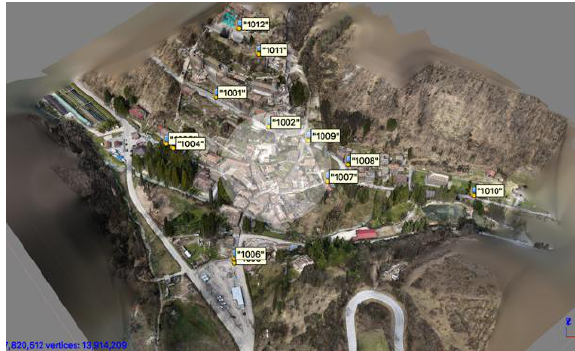
Figure 6. 3D Model of Castelsantangelo sul Nera